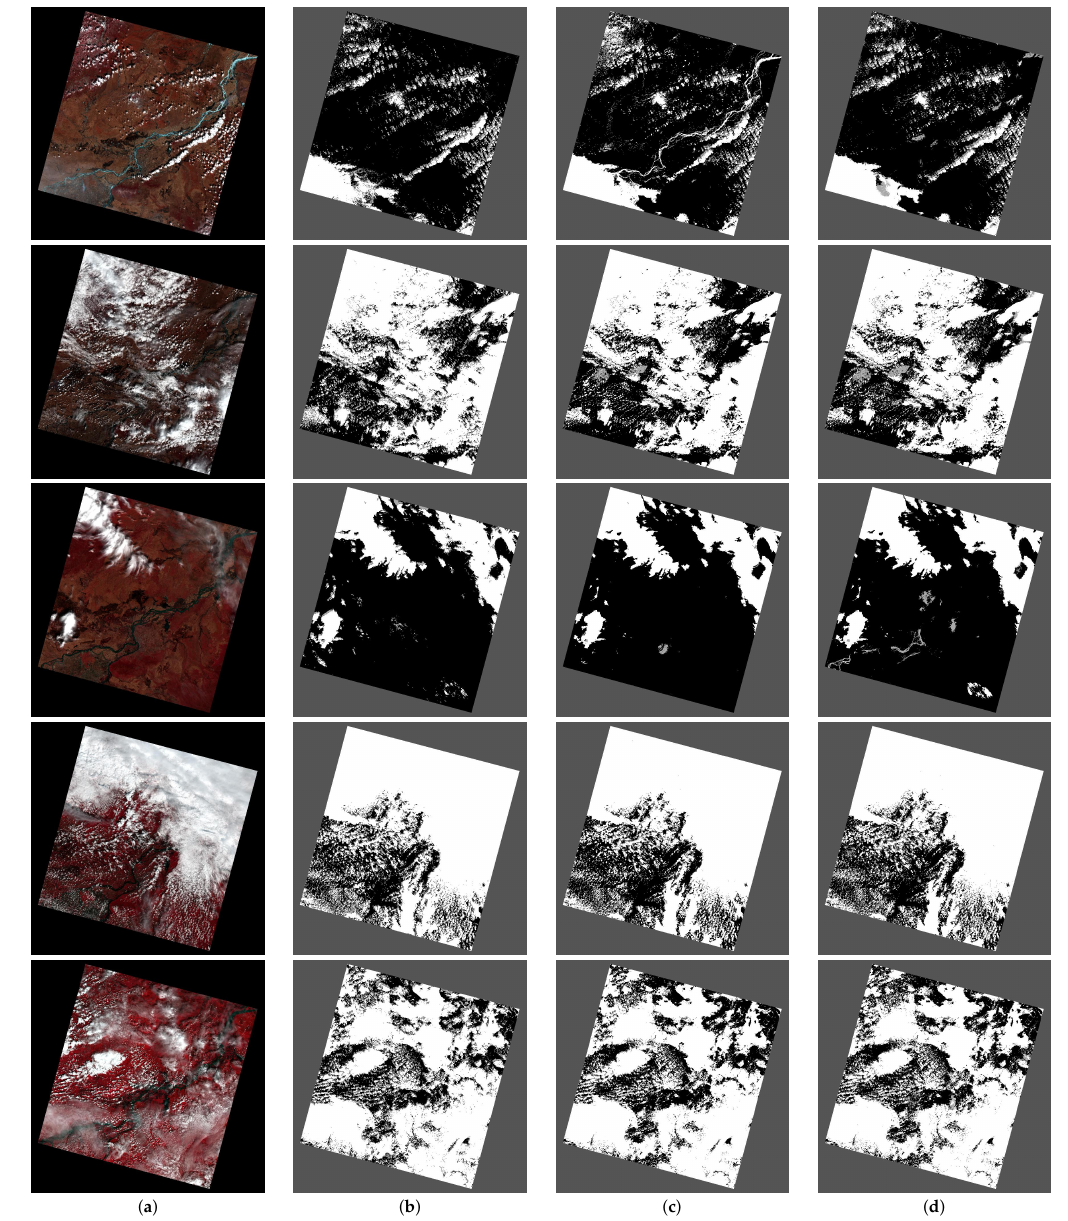
Figure 15. Segmentation results of four-band and seven-band models (L8, Path 113, Row 26): ( a ) false-color image for visualization; ( b ) reference; ( c ) results of the four-band model; and ( d ) results of the seven-band model. Bands 5 NIR, 4 Red, and 3 Green are combined together as RGB channels to construct a false-color image for visualization. Visually, few differences can be found between the two